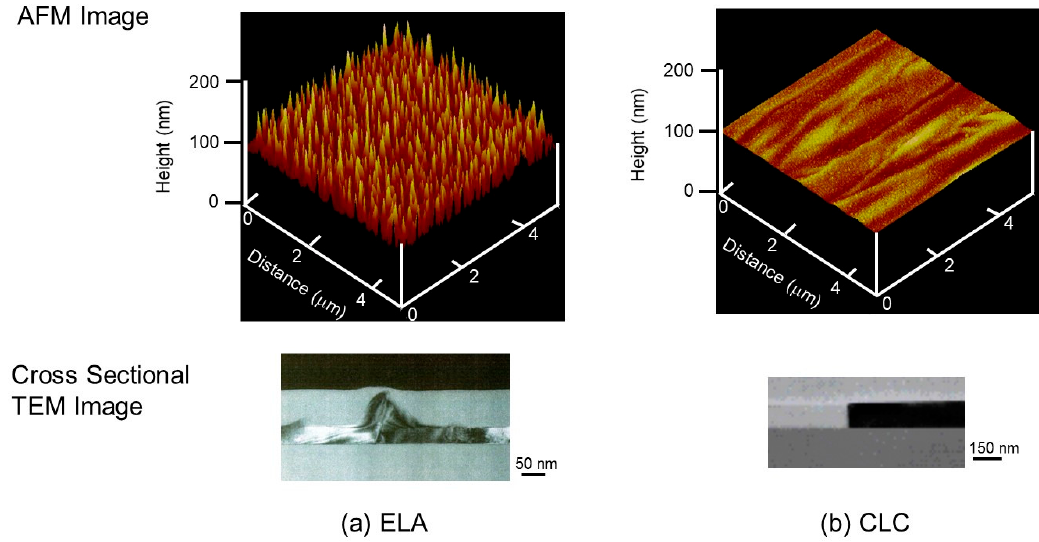
Figure 4. Surface roughness. AFM and cross-sectional TEM images of the crystallized films. ( a ) crystallized by ELA. ( b ) crystallized by CLC. The brightness change in TEM corresponds to crystal orientation change. Conditions of sample fabrication and crystallization are the same as those in Figure 3.